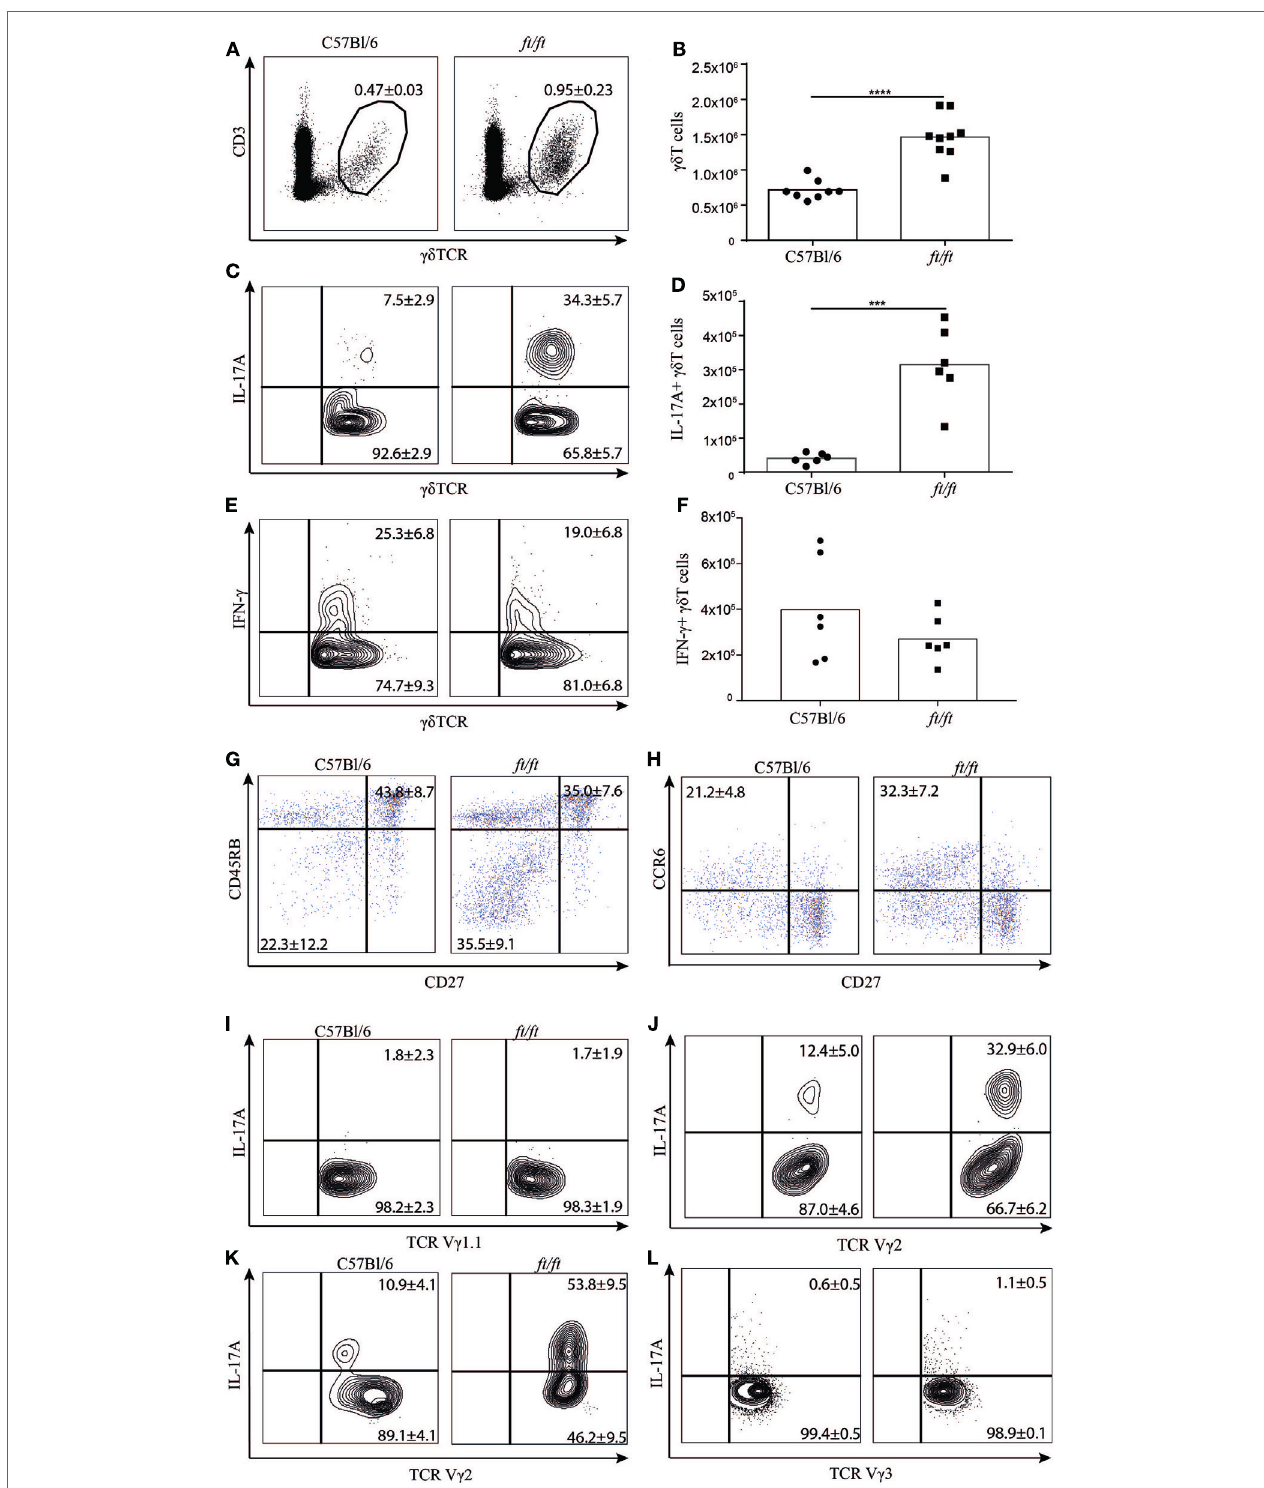
FigUre 1 | Increased numbers of γδ T17 cells in the spleen and epidermis of ft/ft mice. (a–J) Flow cytometric analyses of spleen cells from 8 to 12 weeks old C57Bl/6 and ft/ft mice. (a) Fraction of CD3 ε + TCR γδ + spleen cells. (B) Absolute numbers of CD3 ε + TCR γδ + spleen cells. (c–F) Fraction and absolute numbers of (c,D) IL-17 + and (e,F) IFN- γ + TCR γδ + cells. (g,h) Dot plots showing CD27 versus CD45RB and CD27 versus CCR6 expression of TCR γδ + cells. (i,J) Plots showing IL-17 expression on TCR V γ 1.1 + or TCR V γ 2 + . (K,l) Plots showing IL-17 expression on TCR V γ 2 + and TCR V γ 3 + cells from the epidermis. Data are representative of two to three independent experiments with three to four mice in each. The mean percentages ± SD are given for the relevant populations in the plots.